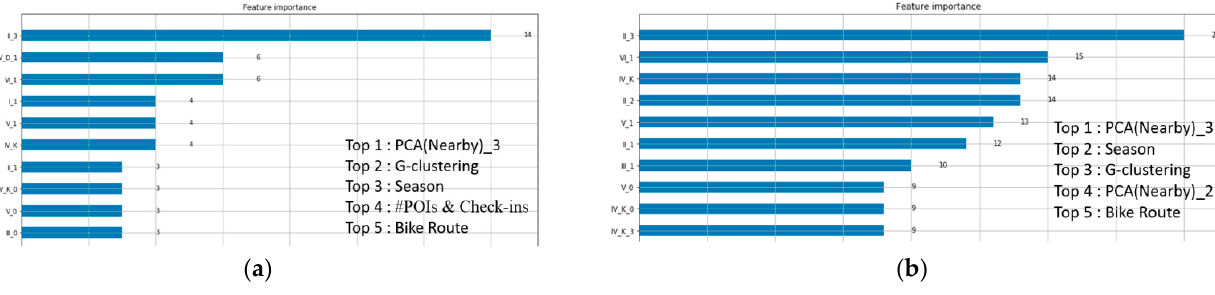
Figure 10. Feature importance of Batch 2. ( a ) Represents rental demand, and ( b ) represents the drop-off one.